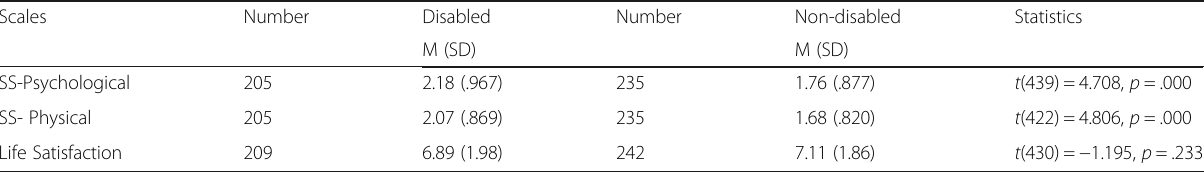
Table 4 Differences between groups relative to scales SS-Psychological, SS- Physical Life and Life Satisfaction